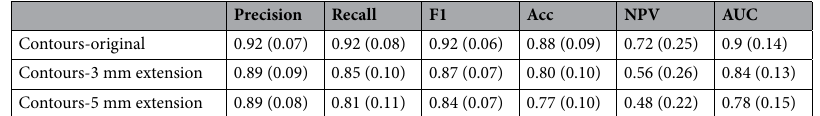
Table 3. The distinction of NTM lymphadenitis from pyogenic lymphadenopathy. Reported results indicate the mean and standard deviation (in brackets) across 100 runs.